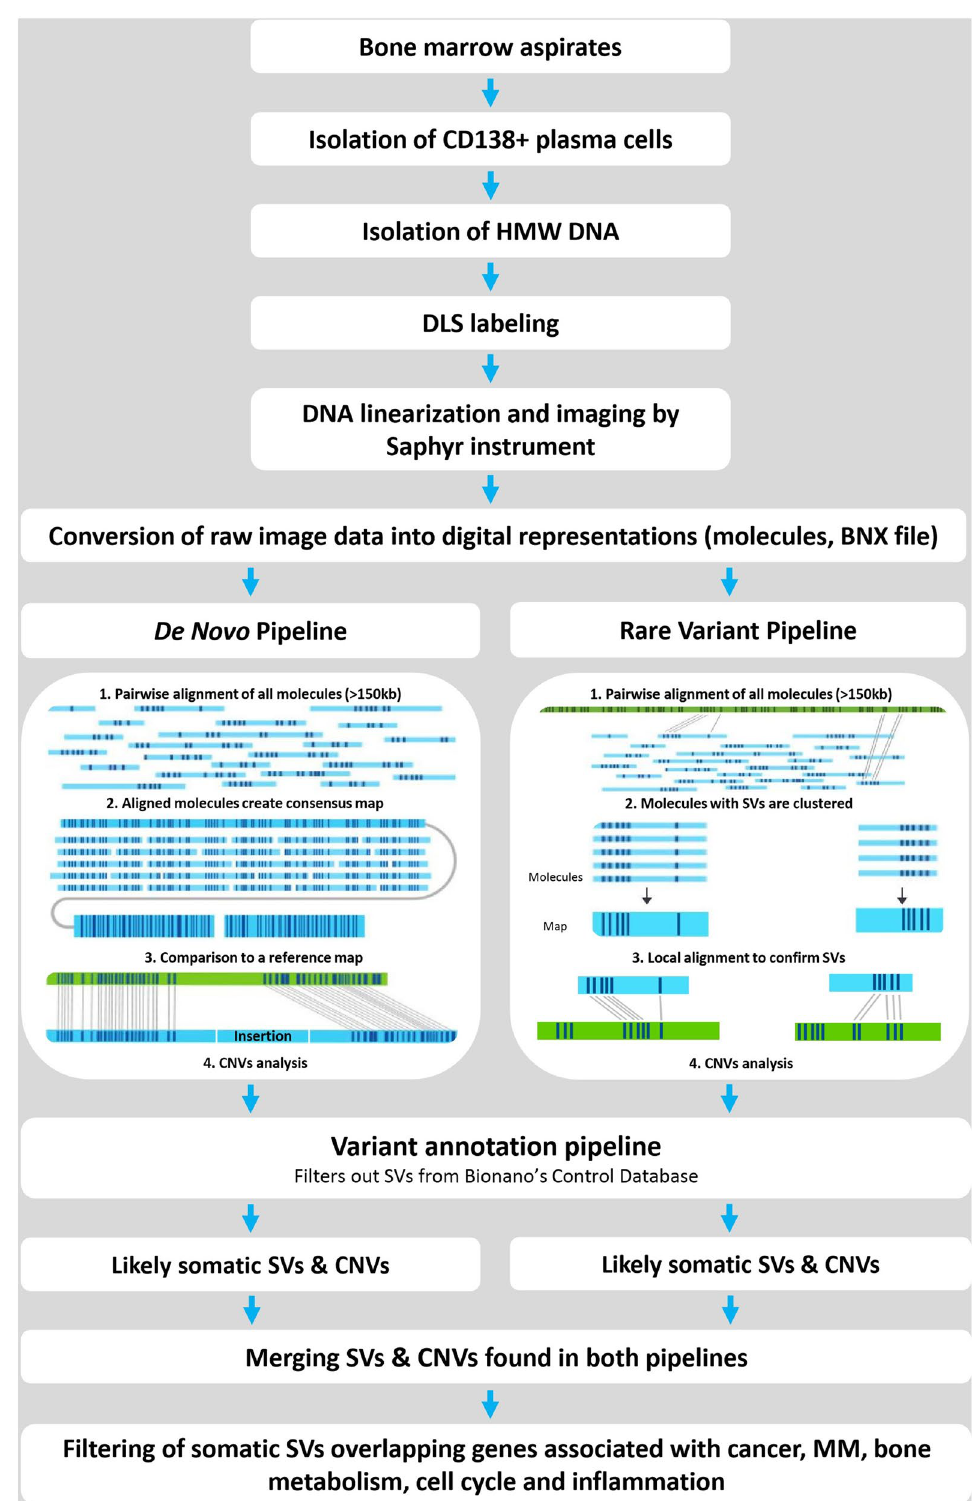
Figure 1. Workflow of optical mapping and bioinformatics pipelines used. HMW DNA is isolated from CD138+ plasma cells of BM aspirates and labelled by DLS chemistry in specific sequences across entire genomes. Labelled DNA is loaded on the chip and linearised and visualised in a Saphyr instrument. Images are converted to BNX molecules. The architecture of the bioinformatics pipeline includes two pipelines (de novo and rare variant), constructing optical genome maps and comparing them with a human reference map (hg38), filtering detected variants for somatic SVs and merging data from both pipelines. The last step enables a comparison of the data with the gene panels created from NCBI gene